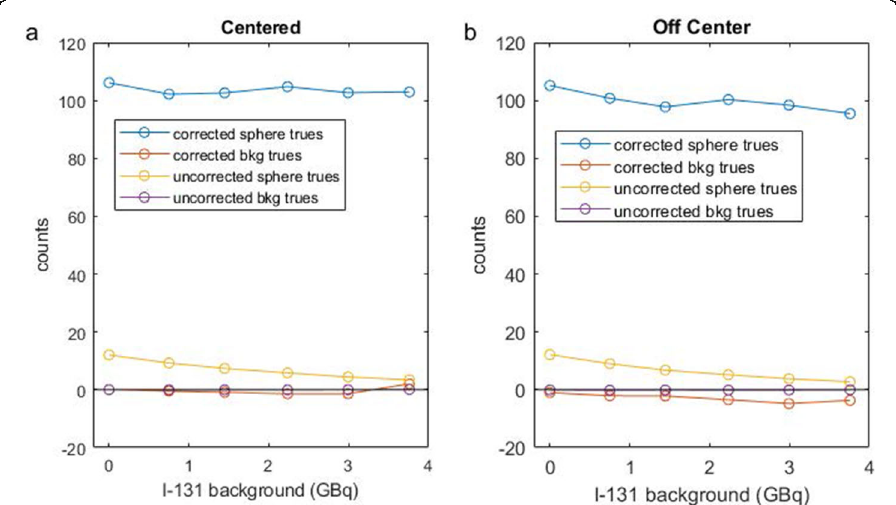
Fig. 4 Corrected and uncorrected number of true events measured in projection space at the center of the 37-mm-diameter sphere of the IEC phantom and in the phantom background, for increasing 131 I activity concentration and for acquisition performed with the phantom centered in the FOV ( a ) and the phantom off-centered ( b